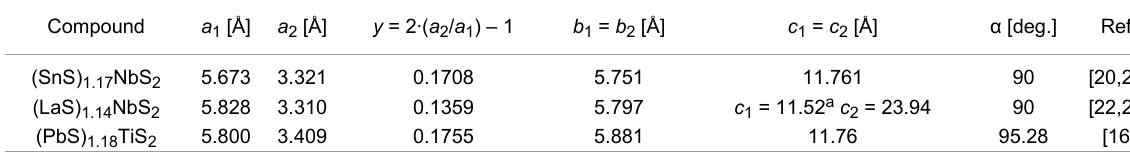
Table 1: Cell parameters of different misfit layer compounds. This table has been taken from Rouxel et al. [3].